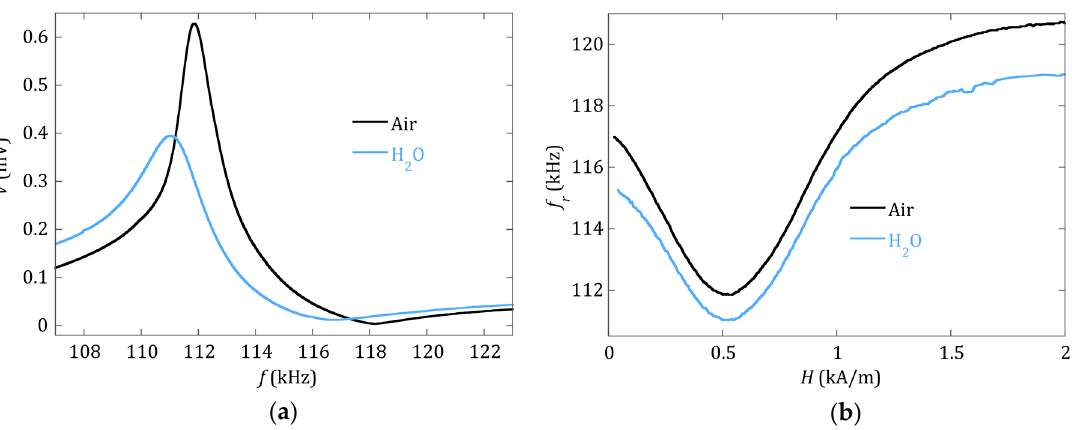
Figure 1. ( a ) Magnetoelastic resonance curves measured at H = 517 A/m, and ( b ) dependence of the resonant frequency ( f r ) with the applied magnetic field, for the Fe 73 Cr 5 Si 10 B 12 strip measured in air and when it is immersed in distilled water.